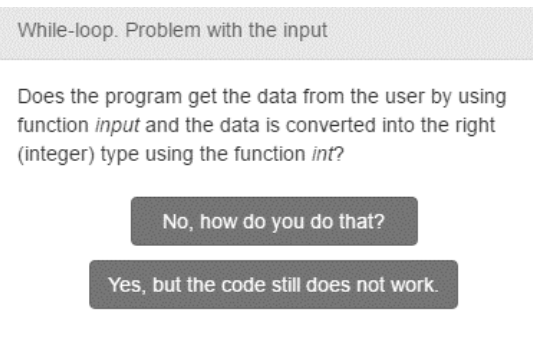
Figure 3 . An example of a troubleshooter question.